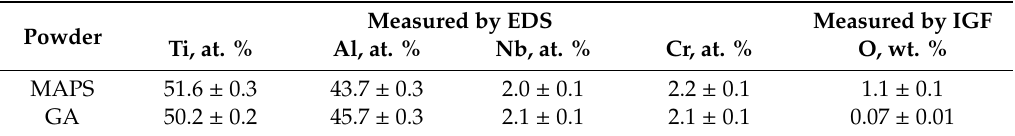
Table 2. The chemical composition of mechanically alloyed plasma spheroidized (MAPS) and GA powders.